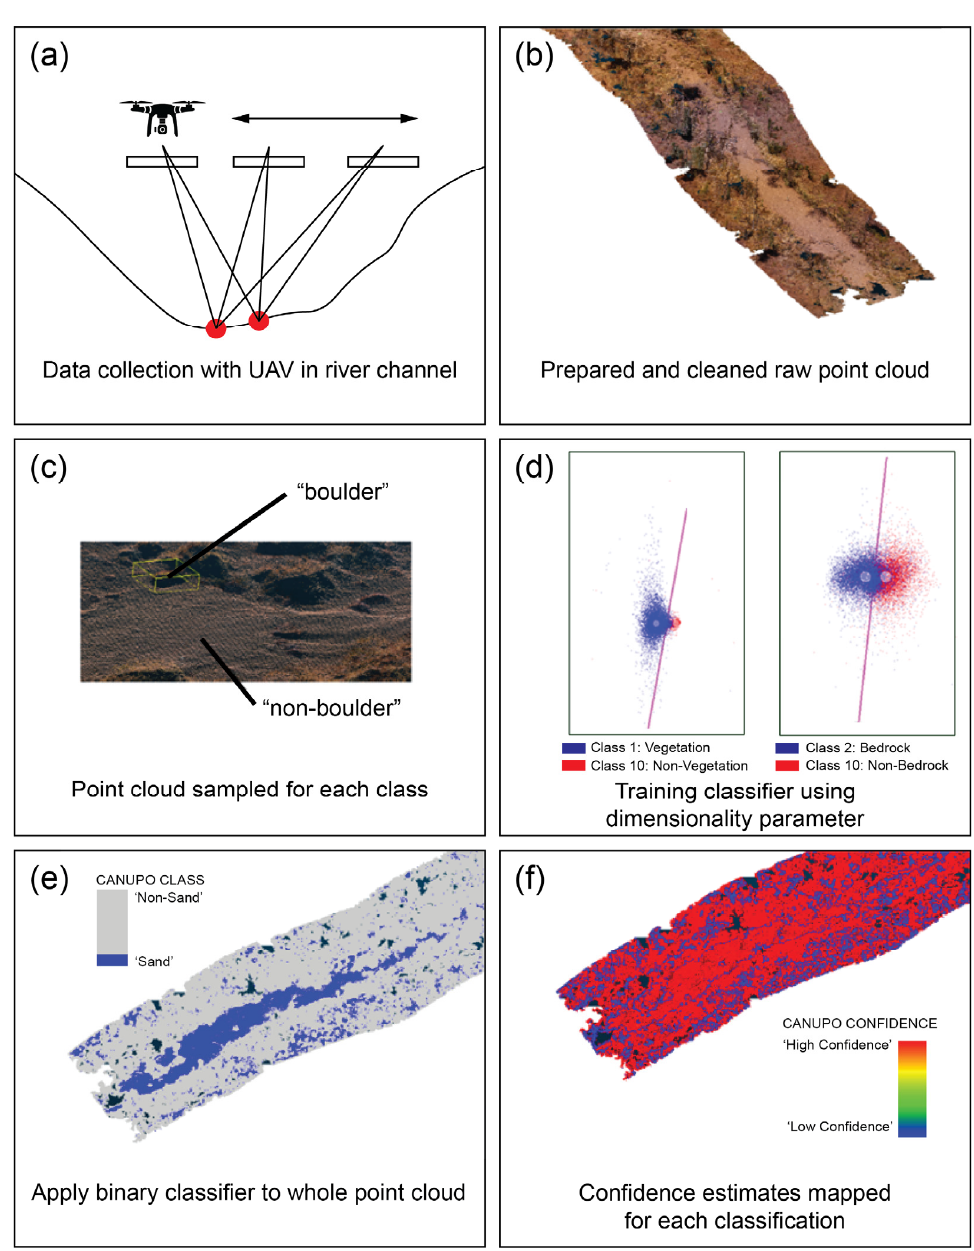
Figure 3. CANUPO procedure diagram. ( a ) Data collection from UAV, ( b ) dense point cloud of river reach, ( c ) classes are discriminated in the point cloud and partitioned. ( d ) Classes are defined to create a classifier file, where points are discriminated using dimensionality parameters across a defined series of scales to decide “class one” or “class two,” ( e ) classifier file is then applied to a whole point cloud, ( f ) confidence estimate is mapped for the classification to show areas of high and low